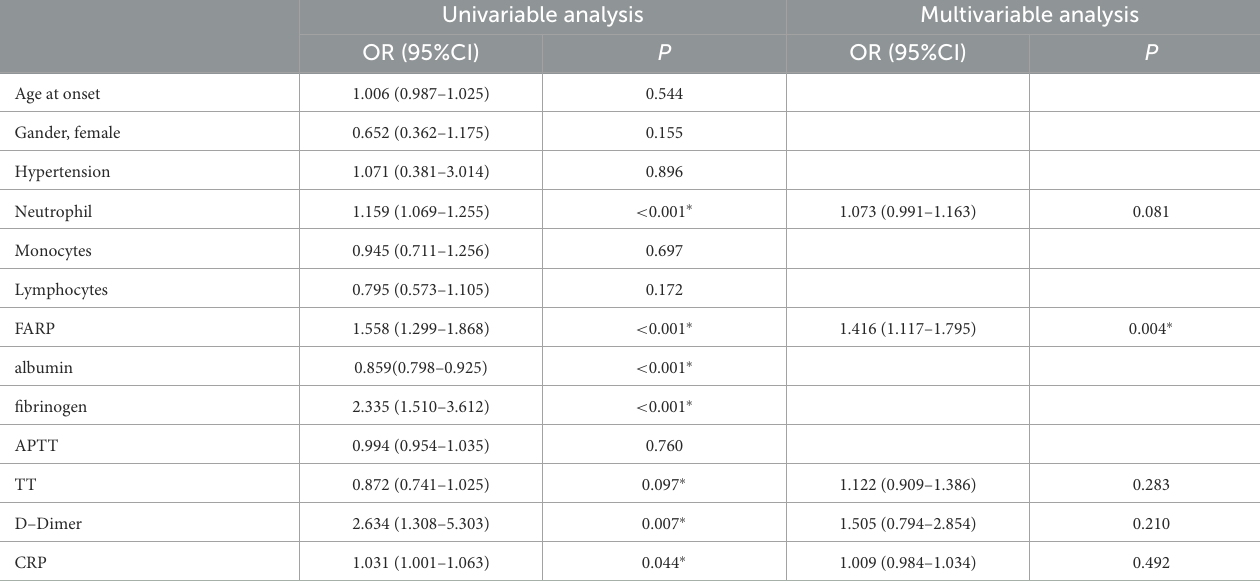
TABLE 6 Binary logistic regression of disease severity in patients with anti-NMDAR encephalitis.